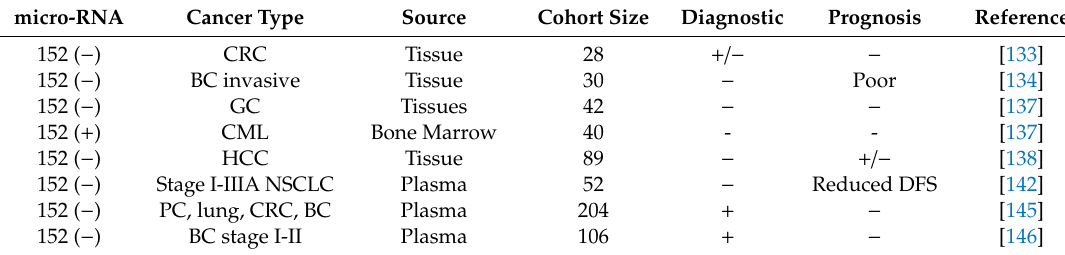
Table 6. Elevated ( + ) or reduced ( − ) miRNA-152 levels are shown, as are the cancer types, source of materials the miRNA was detected from and the patient cohort size. The negative or positive use of the technique in diagnostic or prognostic evaluation of patients are denoted by - or + , respectively. NSCLC, non-small lung cancer cells; CRC, colorectal cancer; PC, prostate cancer; BC, breast cancer; GC, gastric cancer; CML, chronic myelogenous leukemia; HCC, hepatocellular carcinoma.